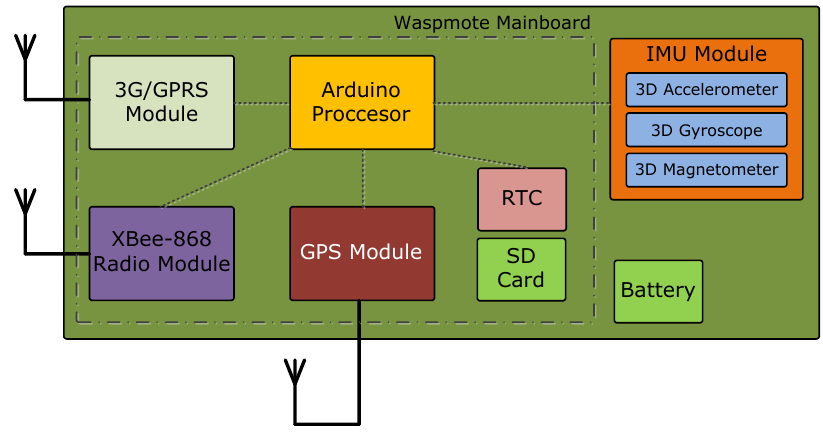
Figure 6. Measurement node composition.